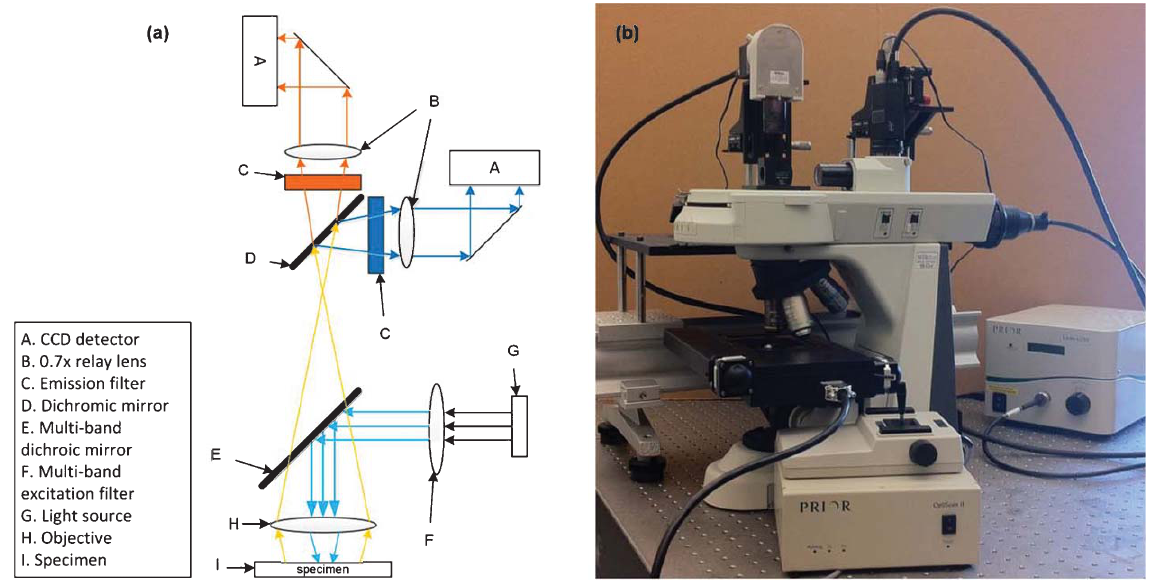
Fig. 1. (a) A schematic draw of the system’s optics. The collimated beam from a 200W metal-halide source first passes through a multi-band excitation filter and reflected by a multi-band dichroic mirror toward the specimen. A second single-band dichroic mirror splits the transmitted emission light into two separate beams for simultaneous detection. (b) The picture of the microscope system.